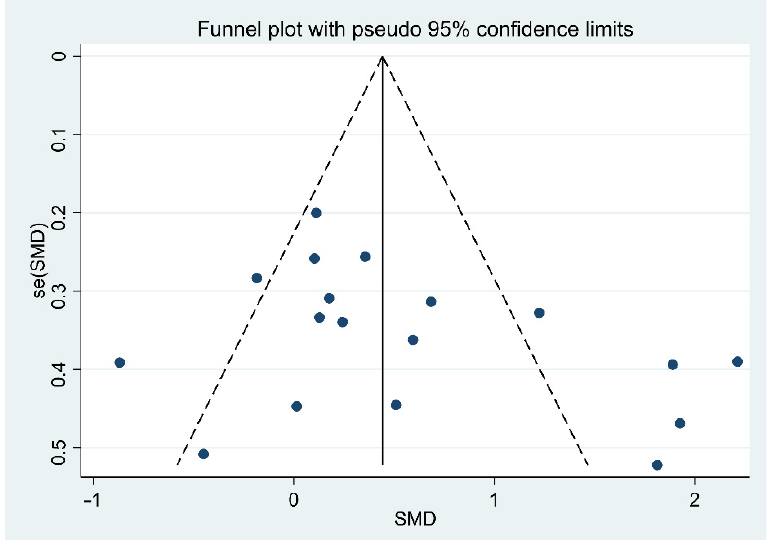
Figure 3. Funnel plot of the meta-analysis of the included research.